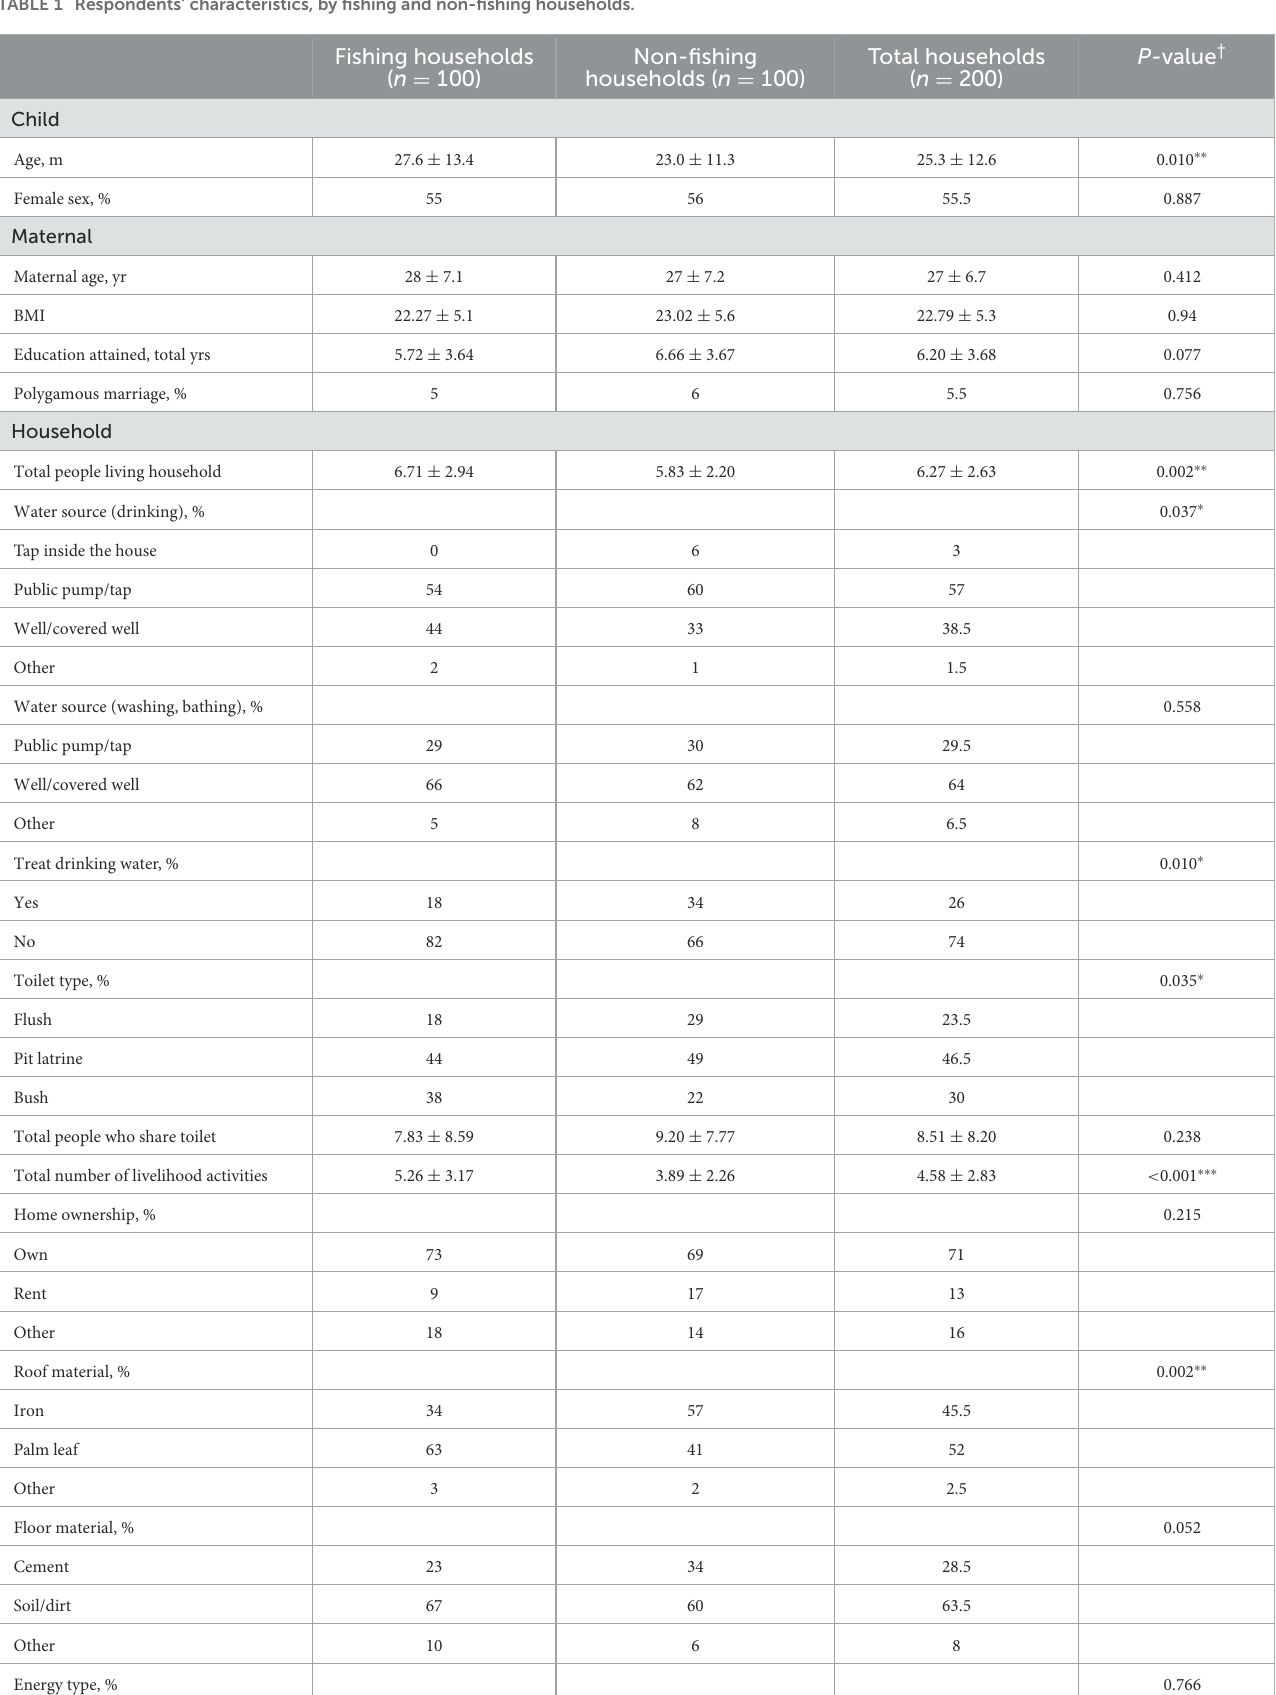
TABLE 1 Respondents’ characteristics, by fishing and non-fishing households.